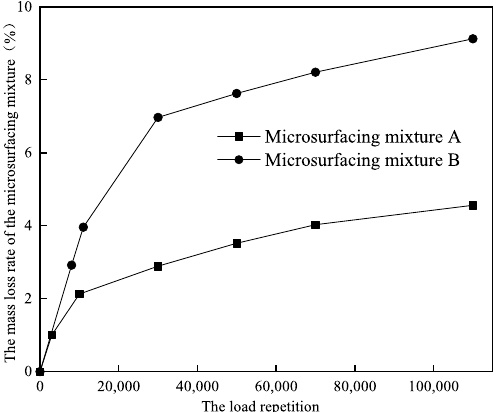
Figure 3. The relationship between mass loss rate and load repetition of microsurfacing